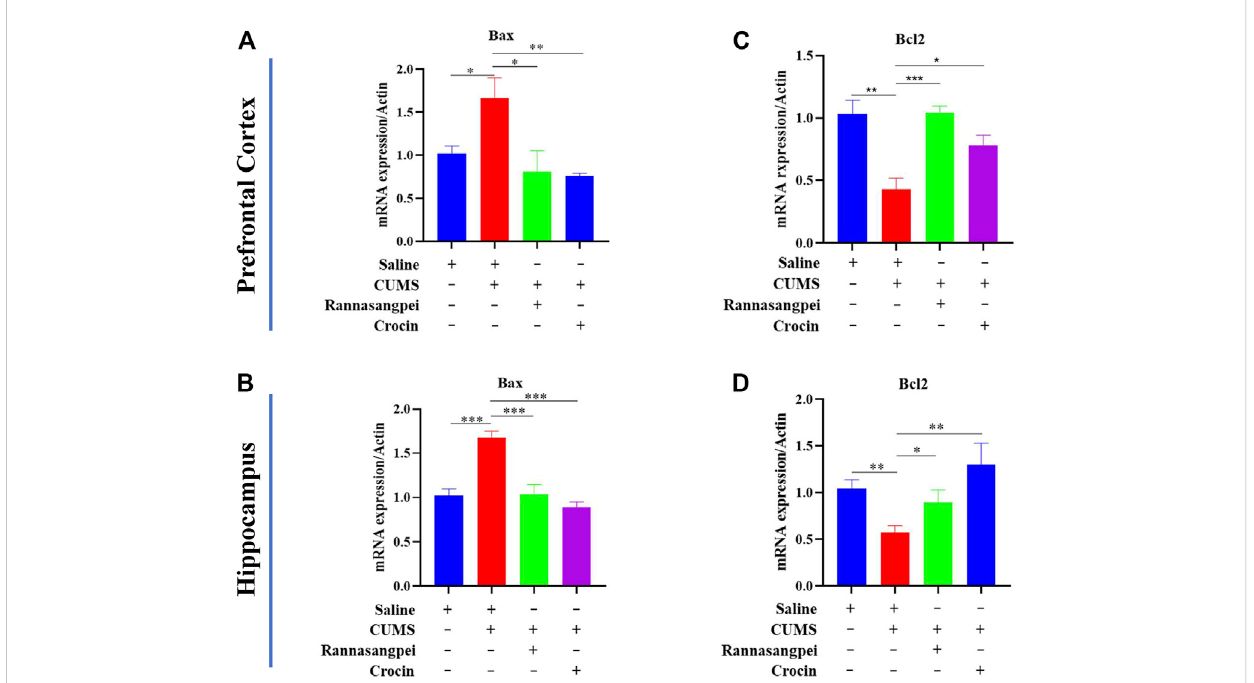
FIGURE 5 RSNP and crocin-1 ameliorated stress-induced apoptosis in the brains of mice (A) Prefrontal cortical and (B) Hippocampal Bax expression levels weresigni fi cantly upregulatedintheCUMS-treated mice, while RSNPand crocin-1administrationabolishedthisalteration. (C) Prefrontalcorticaland (D) HippocampalBcl-2expressionlevelsweresigni fi cantlydownregulatedintheCUMS-treatedmice,whileRSNPandcrocin-1administrationabolishedthis alteration. It should be noted that all the data were normalized to the saline group. RSNP, rannasangpei; CUMS, chronic unpredictable mild stress. N=9.ForANOVAstatistics: (A) ,F (3,36) =4.638, p =0.012; (B) ,F (3,36) =12.08, p < 0.001; (C) ,F (3,36) =18.93, p < 0.001; (D) ,F (3,36) =4.358, p =0.011;* p < 0.05, ** p < 0.01, *** p < 0.001.